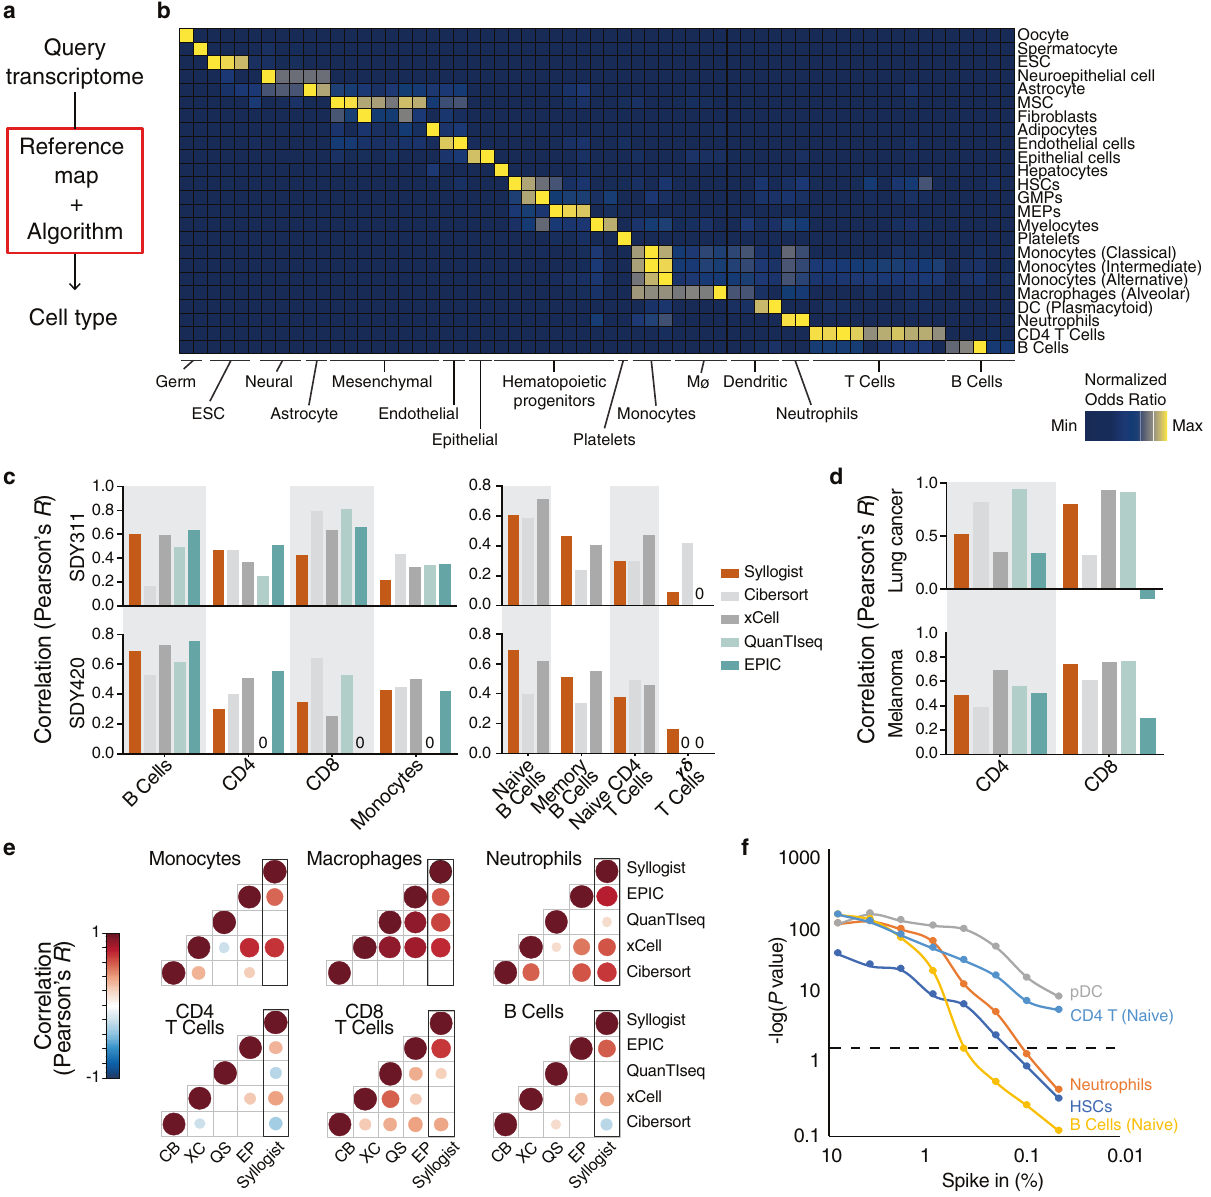
Fig. 1 Cell type estimation using transcriptomes. a Simpli fi ed work fl ow of Syllogist for detection and relative quantitation of cell types from bulk tissue transcriptomes. b Heat map comparing the number of genes enriched for each published positive control sample (rows) and cell type (columns) over random enrichment. Each colored box represents a normalized odds ratio of the respective Fisher ’ s exact test ranging from 0 (blue) to 1 (yellow). ESC Embryonic stem cell, MSC Mesenchymal stem cell, HSCs Hematopoietic stem cells, GMPs Granulocyte – monocyte progenitors, MEPs Megakaryocyte – erythroid progenitors, DC Dendritic cell. c Comparison of Syllogist with CIBERSORT, xCell, QuanTIseq and EPlC. Bar plots represent the Pearson correlation coef fi cients calculated by comparing the Syllogist odds ratios, the CIBERSORT, xCell, QuanTIseq, and EPlC scores with the quantitative data of PBMC fractions measured by CyTOF (SDY311 [https://www.immport.org/shared/study/SDY311], n = 61 patients and SDY420 [https://www.immport.org/shared/study/SDY420] , n = 104) 19 . d same as ( c ), applying melanoma ( n = 32 samples) and lung cancer ( n = 8) datasets with paired quantitative data of CD4 and CD8 T cells by immuno fl uorescence 22 . e Correlation matrices represent the agreement of Syllogist with four established computational methods for the indicated immune cell types. Pearson correlation coef fi cients with p <0.05 are shown as circles, with circle size and color matching Pearson correlation coef fi cients from − 1 (blue) to 1 (dark red). Empty squares represent correlation coef fi cients of p ≥ 0.05). CB Cibersort; QS QuanTIseq, XC xCell, EP EPIC. p values determined using a two-tailed Student ’ s t -test. f Line chart represents − log10 ( p values) obtained by comparing paired samples with and without spike-in for the indicated cell types at various percent spike-in ( n = 200 brain tissue transcriptomes, two-tailed paired Student ’ s t- test). pDC plasmacytoid dendritic cells, HSCs Hematopoietic stem cells. The horizontal dashed line indicates the threshold considered for signi fi cance ( p = 0.05). Source data of ( c ), ( d ) and ( f ) are provided as a Source Data fi